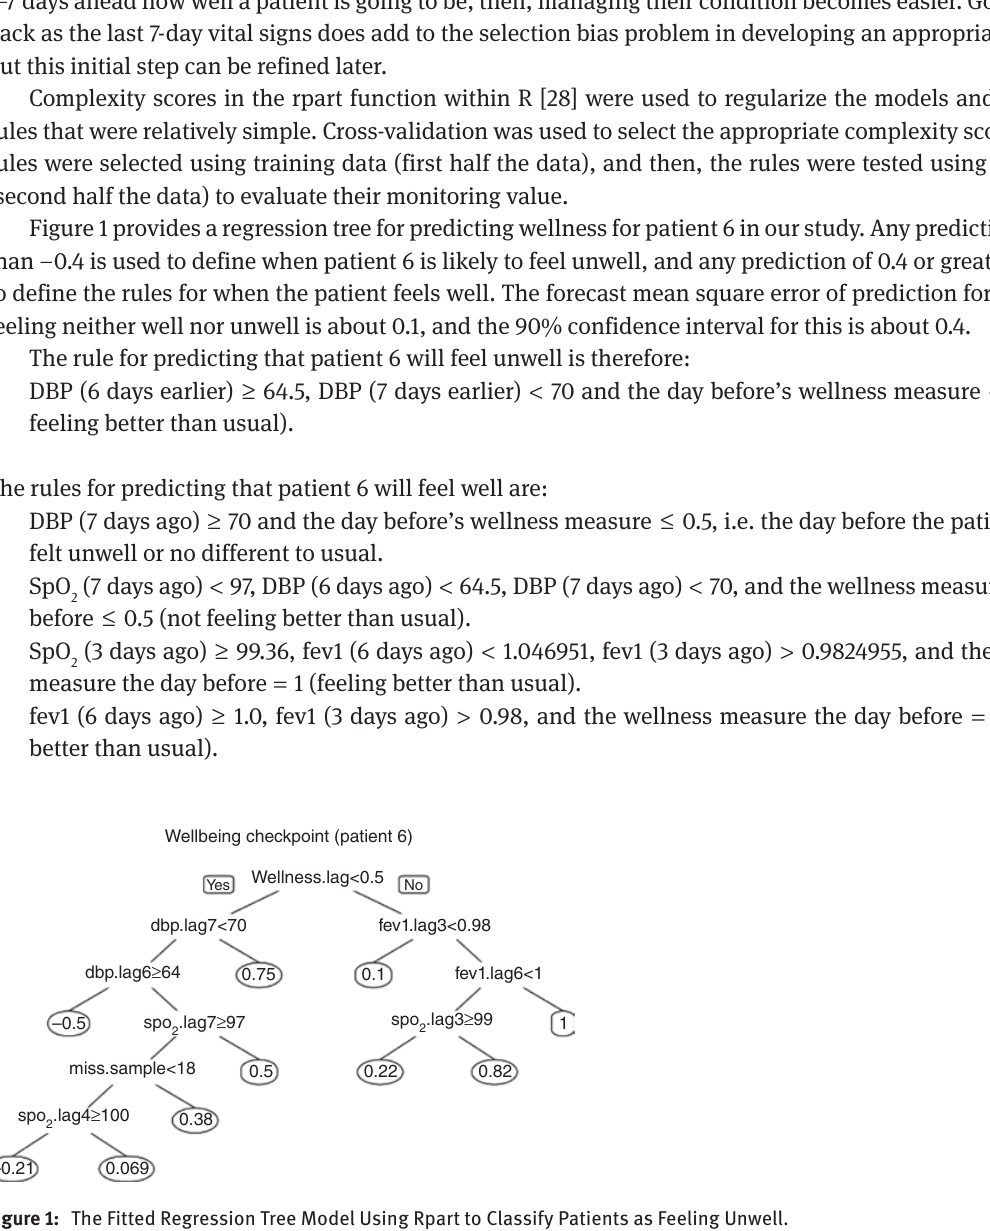
Figure 1: The Fitted Regression Tree Model Using Rpart to Classify Patients as Feeling